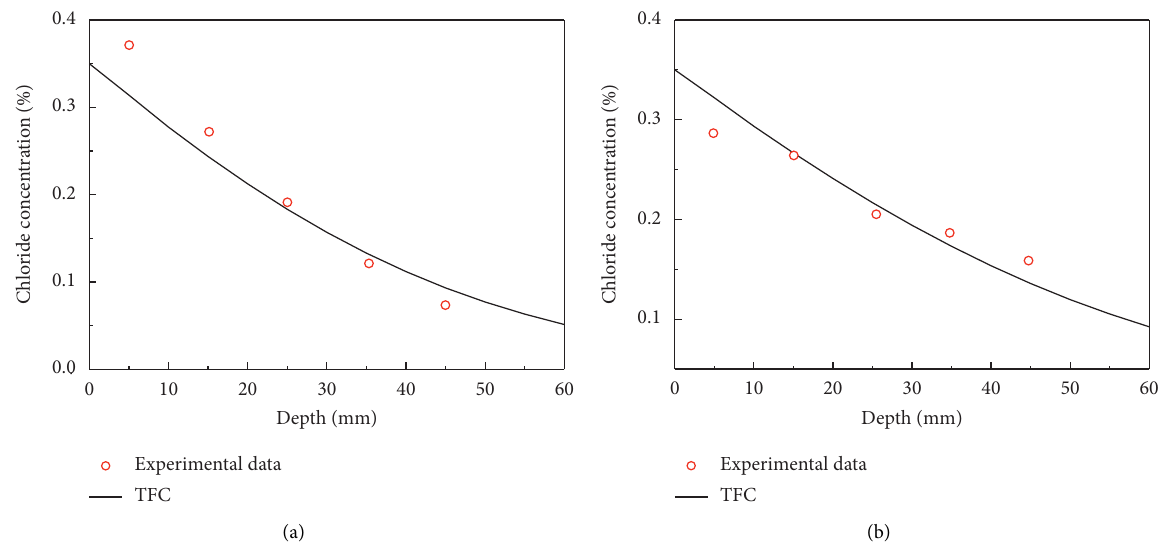
Figure 8: Distribution of chloride concentration with penetration depth. (a) t � 3 years and (b) t � 8